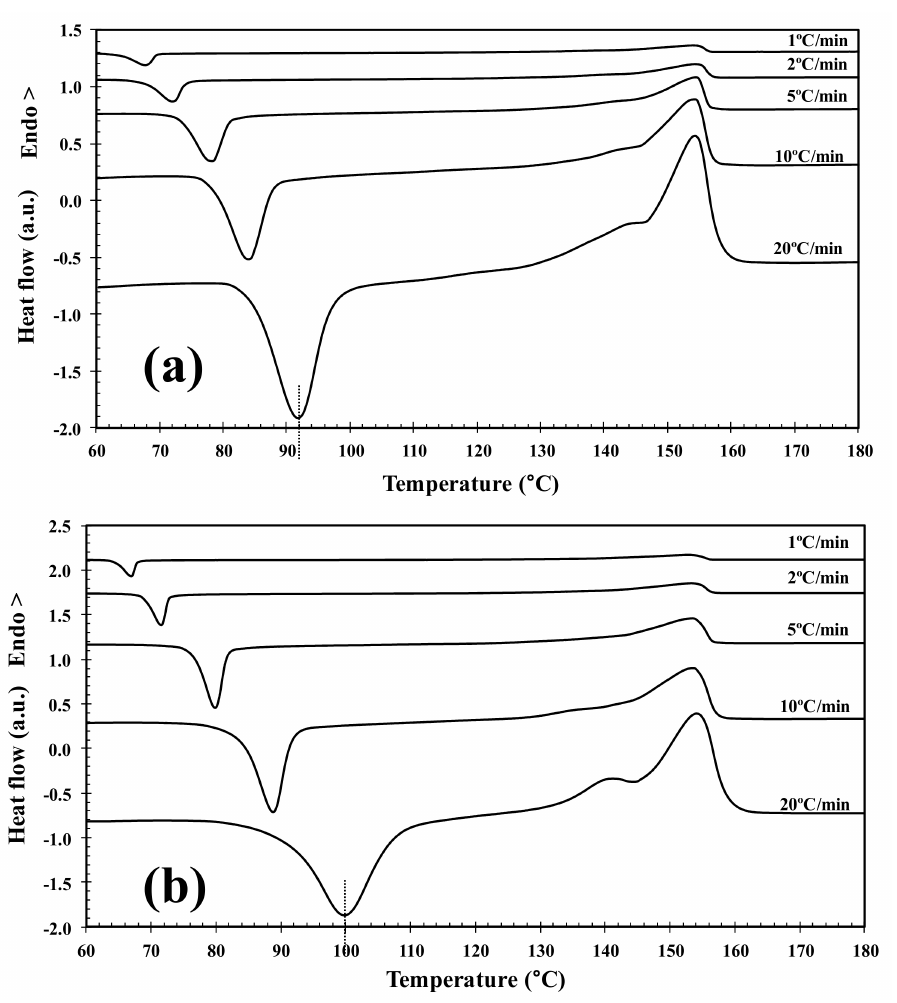
Figure 3. DSC cold-crystallization thermograms of ( a ) PLLA and ( b ) PLLA/2D-WS2 (0.5